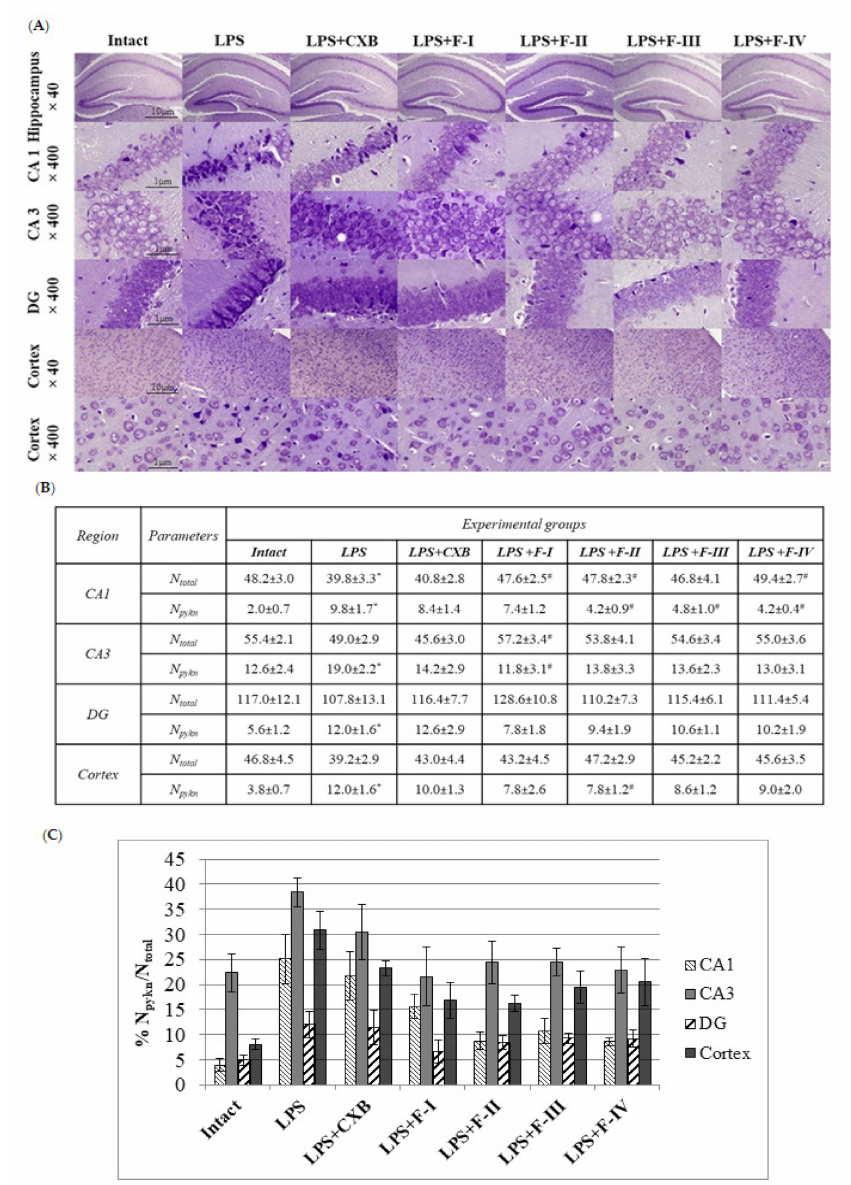
Figure 2. ( A ). Histological sections of the hippocampus (regions CA1, CA3, dentate gyrus DG) and posterior parietal cortex stained with Nissl cresyl violet. Effect of treatment with F-I–F-IV and celecoxib 72 h after LPS injection on linear density of neurons (N total )—panel ( B ) and on the number of pyknotic cells (N pykn )—panel ( C ). Data are provided as mean ± SEM ( n = 3); p < 0.05—* significant when compared with the intact group, #—significant when compared with the LPS